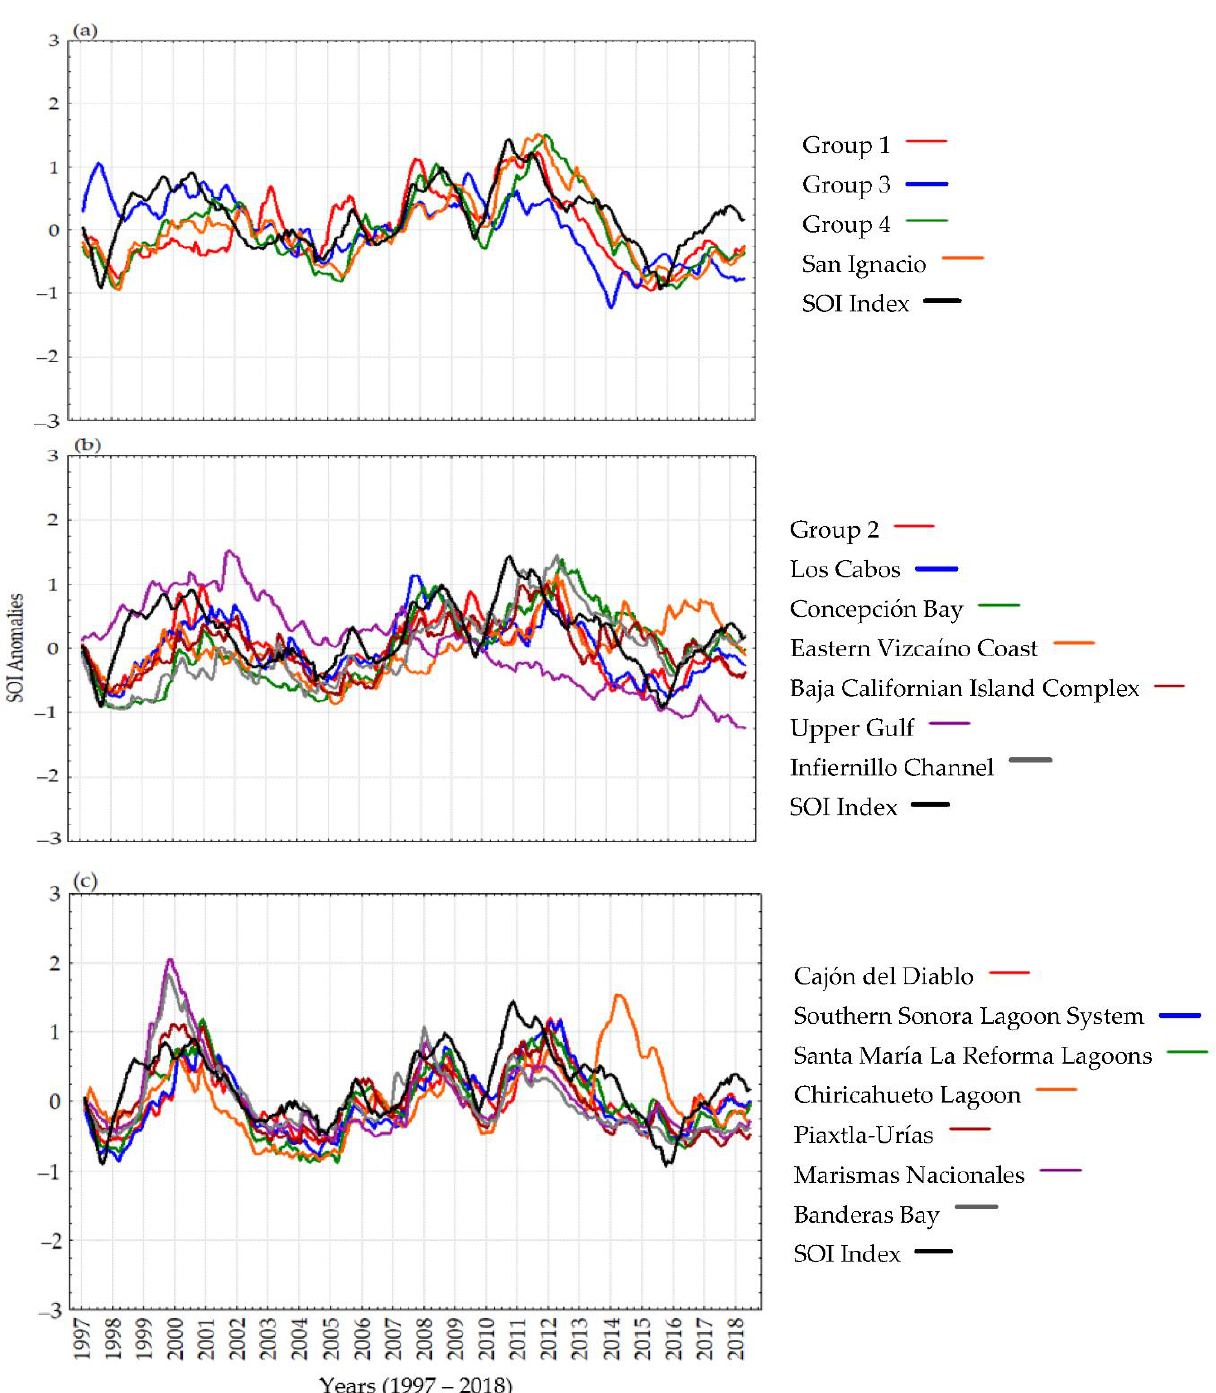
Figure 5. Time series anomalies of Chlorophyll a (Chl a ) for the regions of the northwest of Mexico. South Californian Pacific ( a ); Gulf of California ( b , c ). In addition, monthly images of Chl a corresponding to March and August from 2011 and 2015 were taken to show the variability of the Chl a concentration, derived from the results of the time series, and the time series anomalies where it is observed that the years with greater and lesser Chl a levels are using years characterized as La Niña and El Niño, respectively (Figure 6).